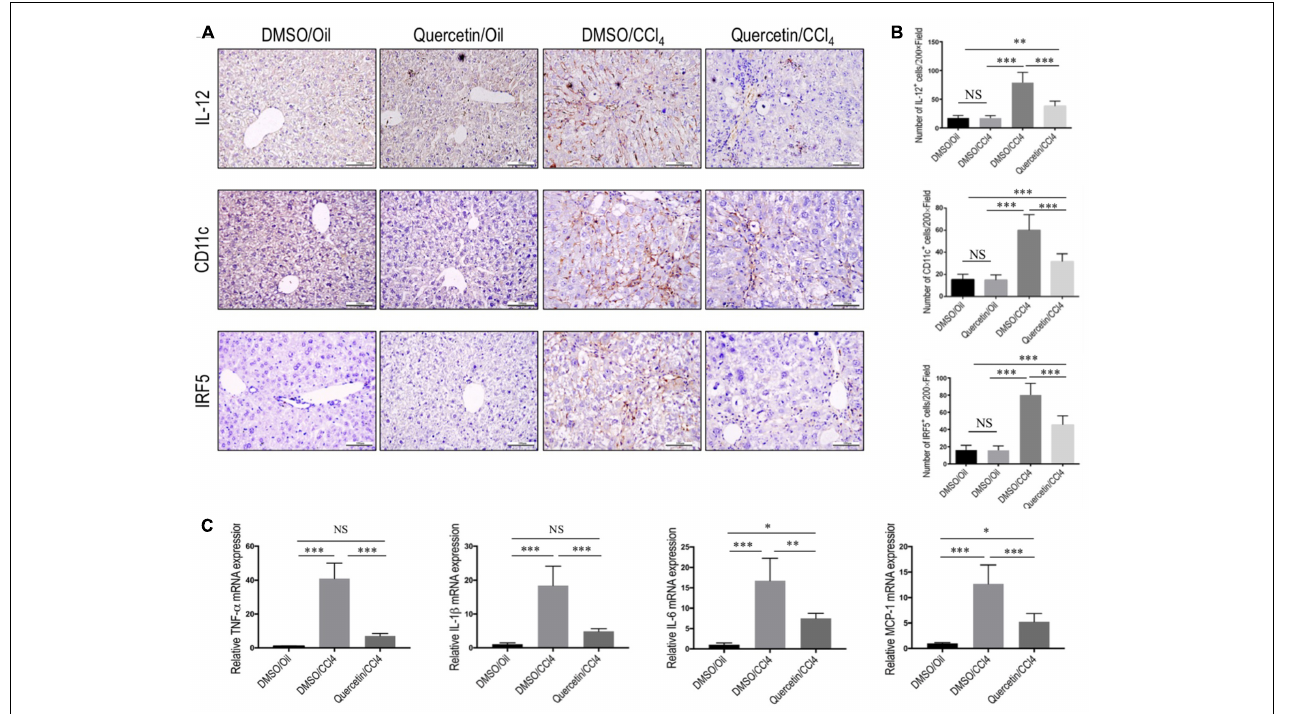
FIGURE 5 | Effect of quercetin on M1 macrophage polarization and expression of inflammatory properties in fibrotic livers. (A) Representative immunostaining of IL-12, CD11c, and IRF5 in liver sections (original magnification: × 200). Scale bar = 100 µ m. (B) Quantification of IL-12, CD11c, and IRF5 immunostaining in the liver from each group. (C) Hepatic M1 polarization genes of TNF- α , IL-1 β , IL-6, and MCP-1 were determined by quantitative RT-PCR, and results are shown as fold change compared with sham-treated control and GAPDH served as loading control ( n = 5). ∗ P < 0.05; ∗∗ P < 0.01; ∗∗∗ P < 0.001; “NS” indicates not